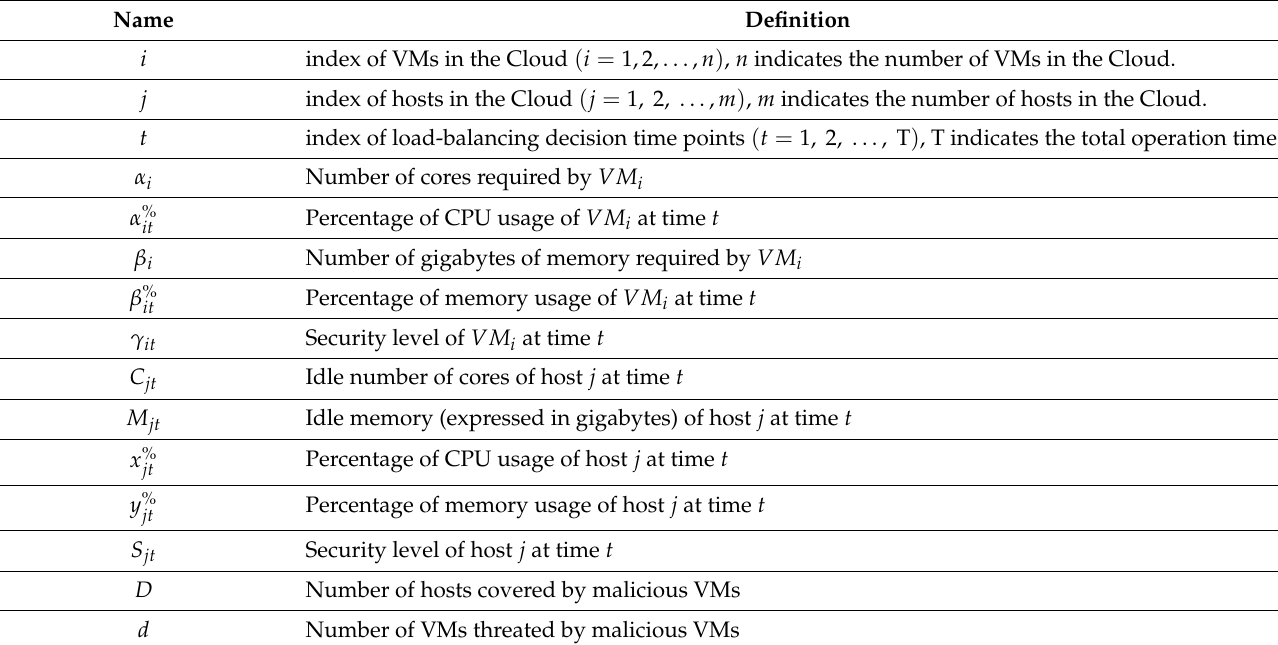
Table 1. Definitions regarding the